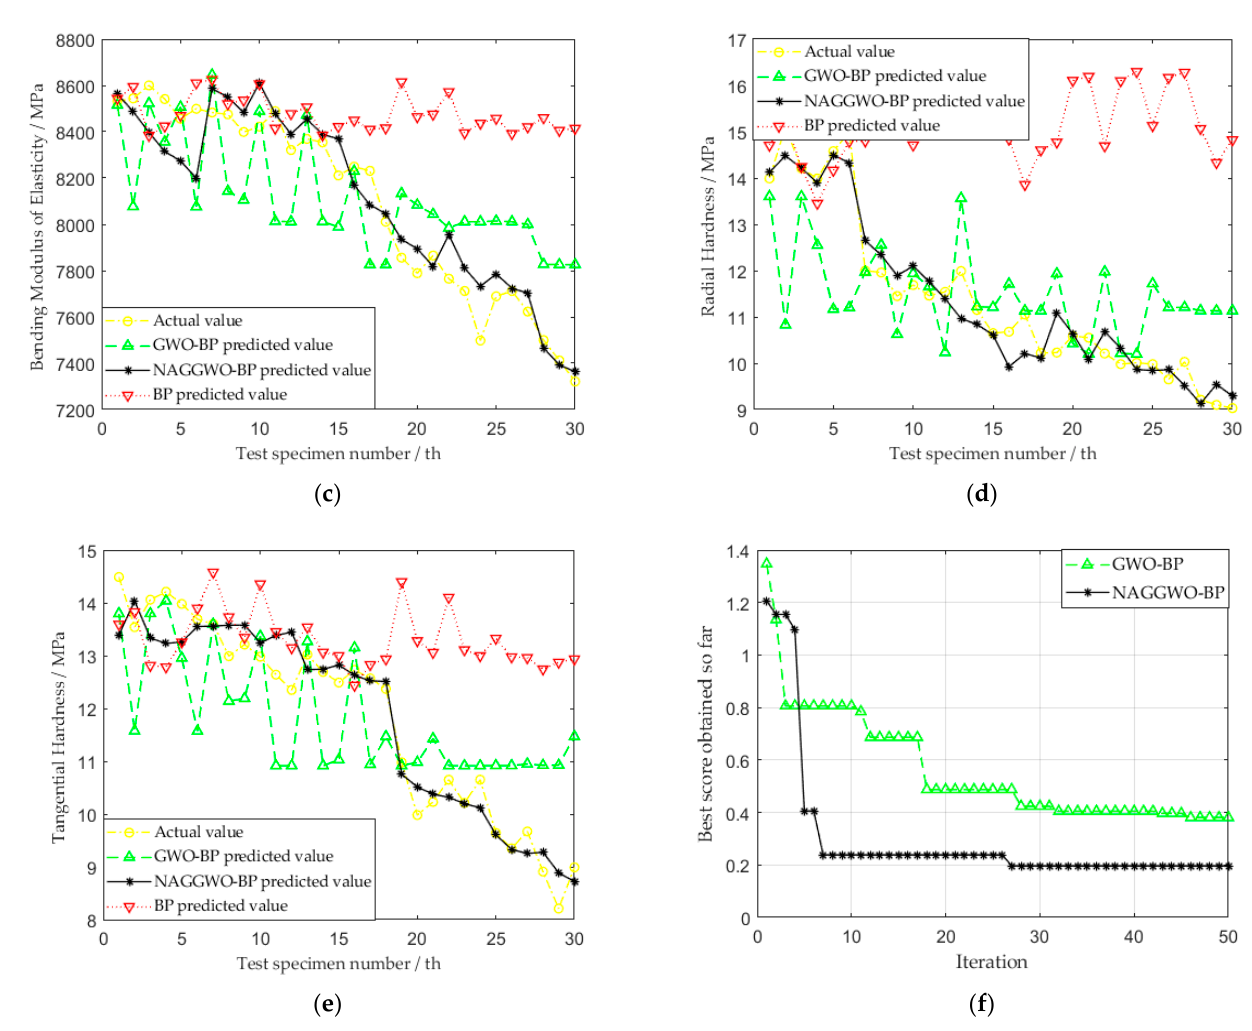
Figure 5. Comparison between predicted results and actual values for different models: ( a ) compressive strength along grain; ( b ) flexural strength; ( c ) flexural modulus of elasticity; ( d ) radial hardness; ( e ) tangential hardness; ( f ) convergence curve of GWO-BP and NAGGWO-BP.